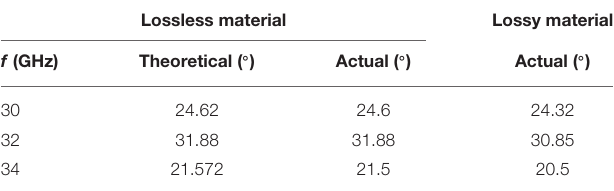
Ex-distribution and the far-field distribution map at 30 and 34 GHz.